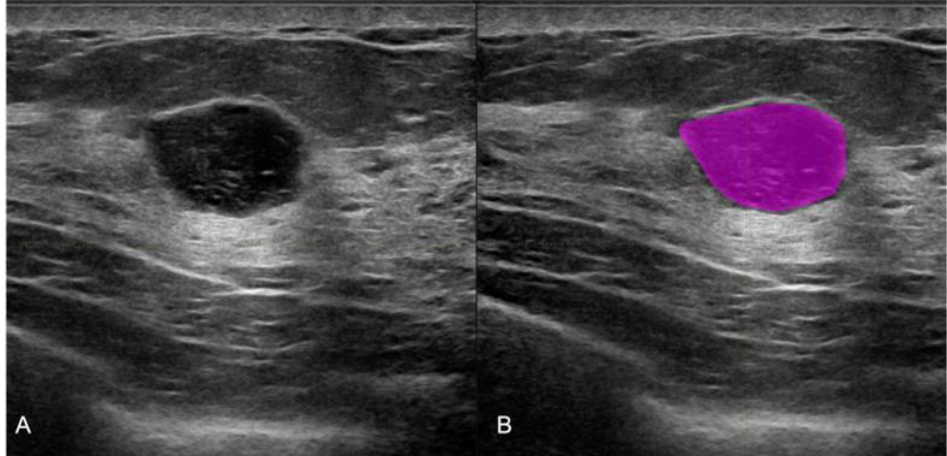
Figure 1. Manual ultrasound image segmentation on LifeX software. ( A ) Round shape breast lesion in the US conventional B mode, ( B ) the manual segmentation with colored ROI obtained with LifeX software. The histological result of the biopsy was that of a